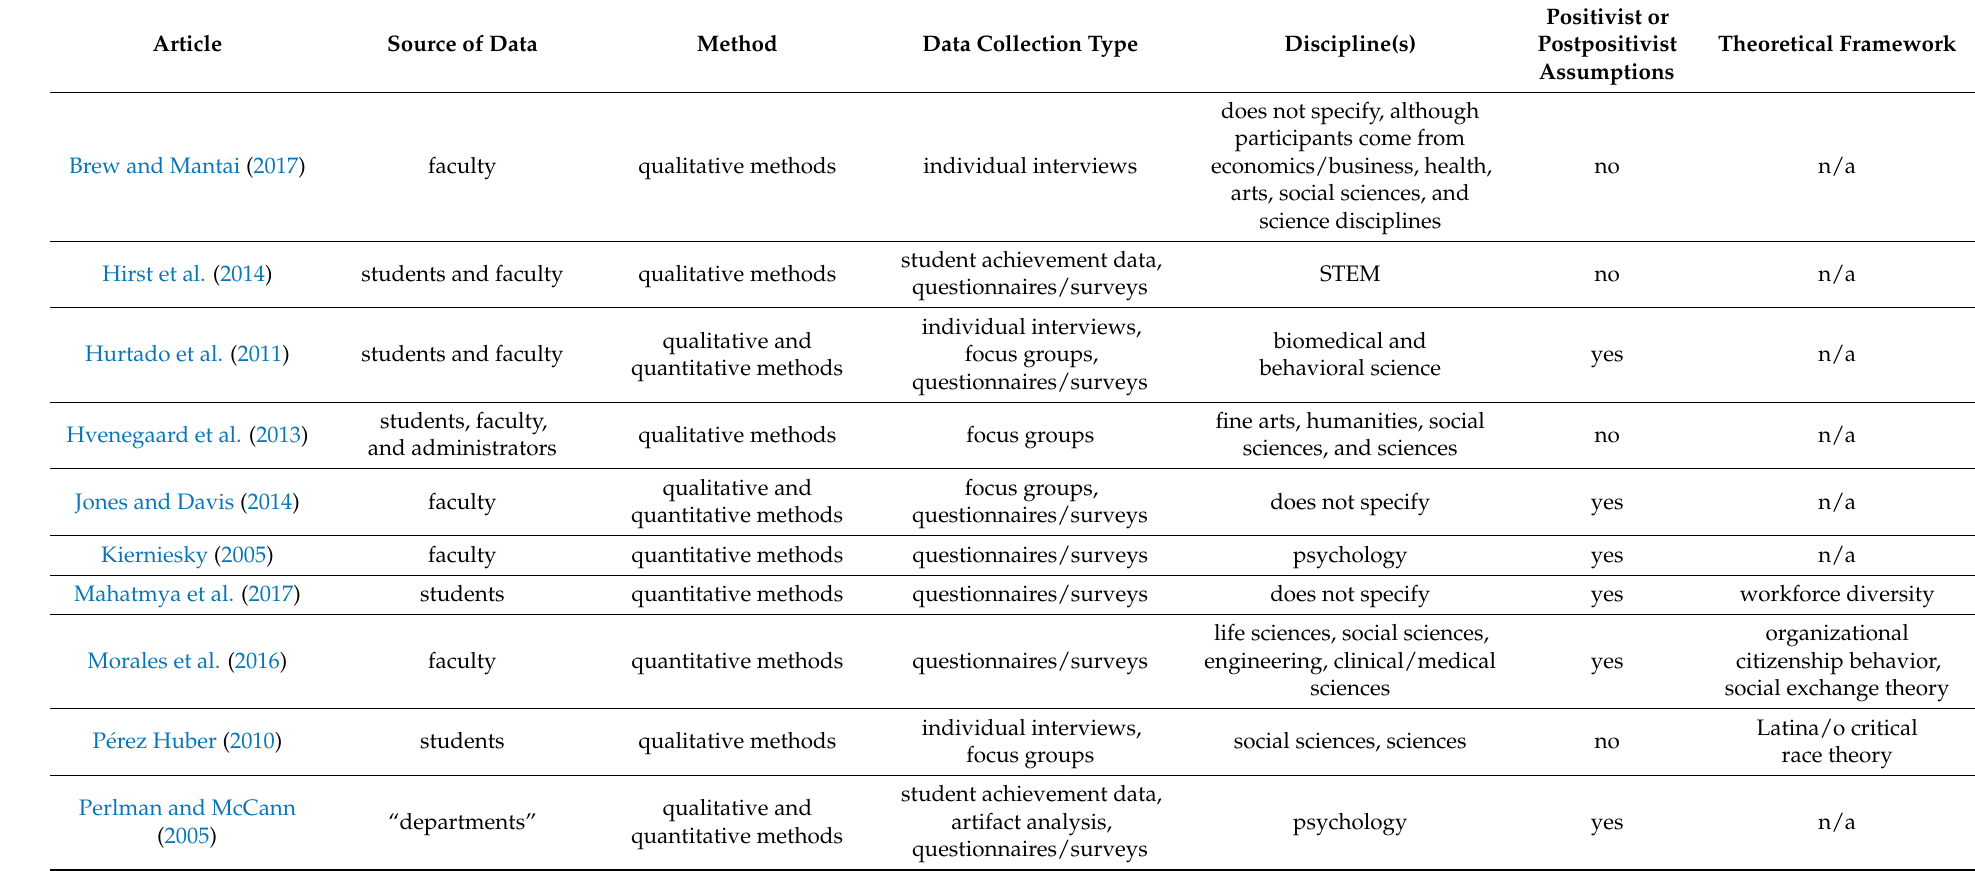
Table 1. Methodological and conceptual similarities shared among the eighteen articles included in this